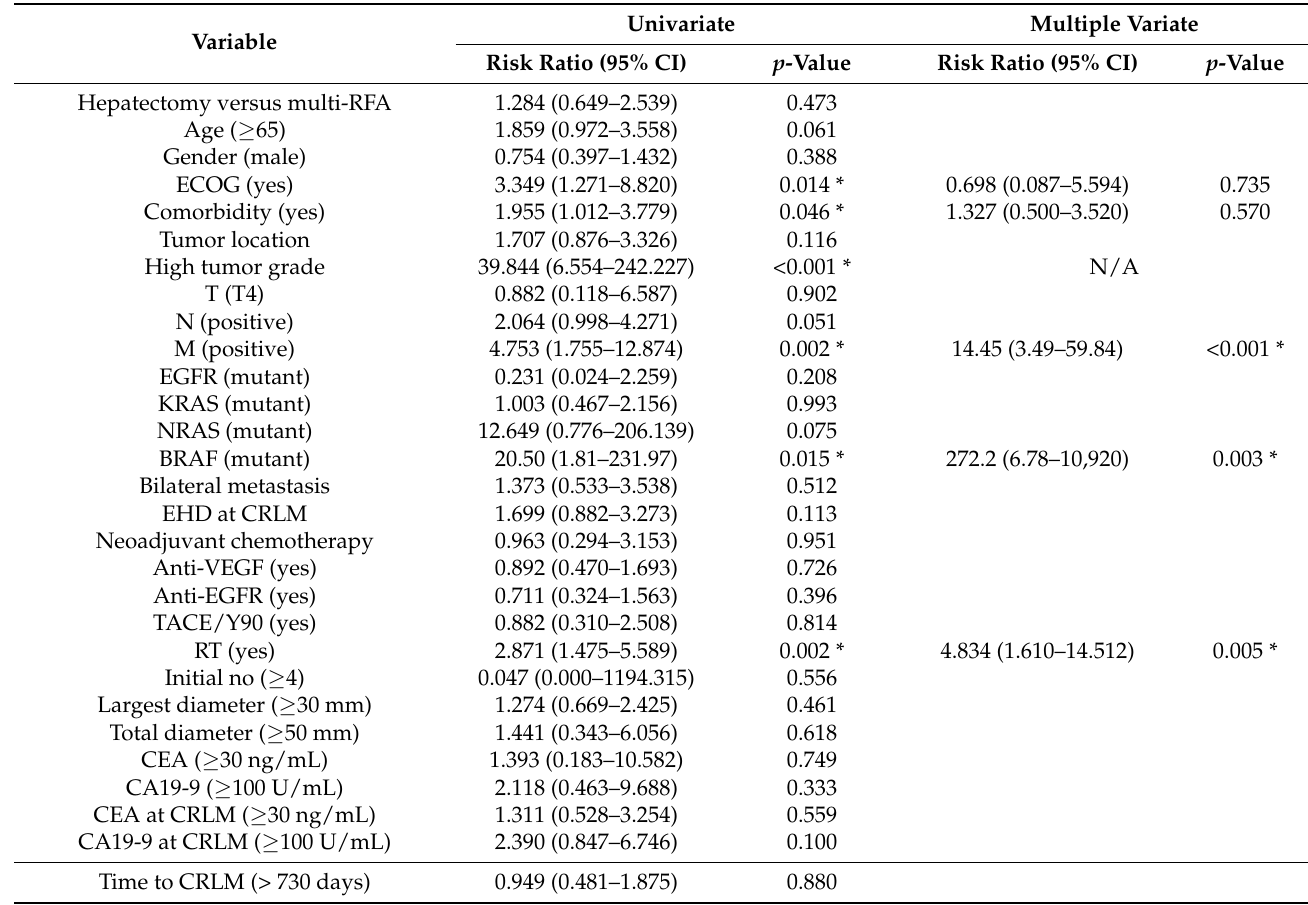
Table 4. Univariate and multiple variate analysis of multi-RFA vs.